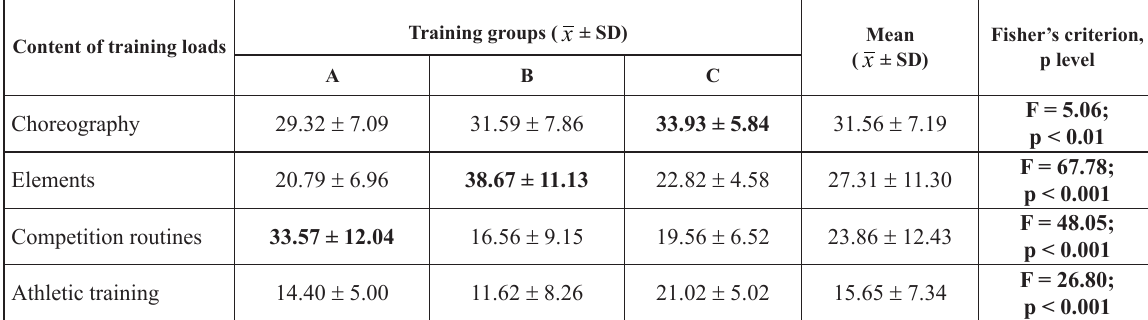
Table 3. Content (%) of training loads of different training programs of 13–14-year-old athletes in rhythmic gymnastics